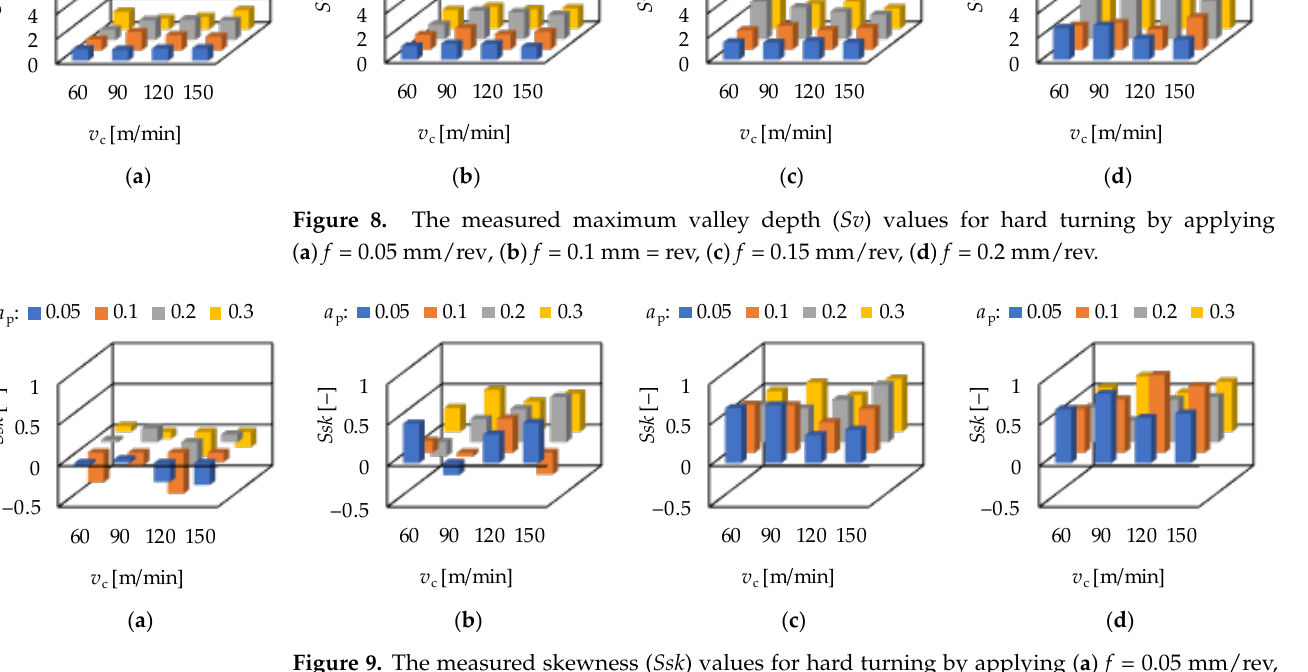
Figure 9. The measured skewness ( Ssk ) values for hard turning by applying ( a ) f = 0.05 mm/rev, ( b ) f = 0.1 mm = rev, ( c ) f = 0.15 mm/rev, ( d ) f = 0.2 mm/rev. If its value is lower 3 or decreasing, the wear resistance increases. By the increase of the feed rate lower Sku values were obtained. When varying the cutting speed on fixed ap and f levels or the depth-of-cut on fixed v c and f , no clear tendencies were observed in the change of the Sku value (Figure 10).